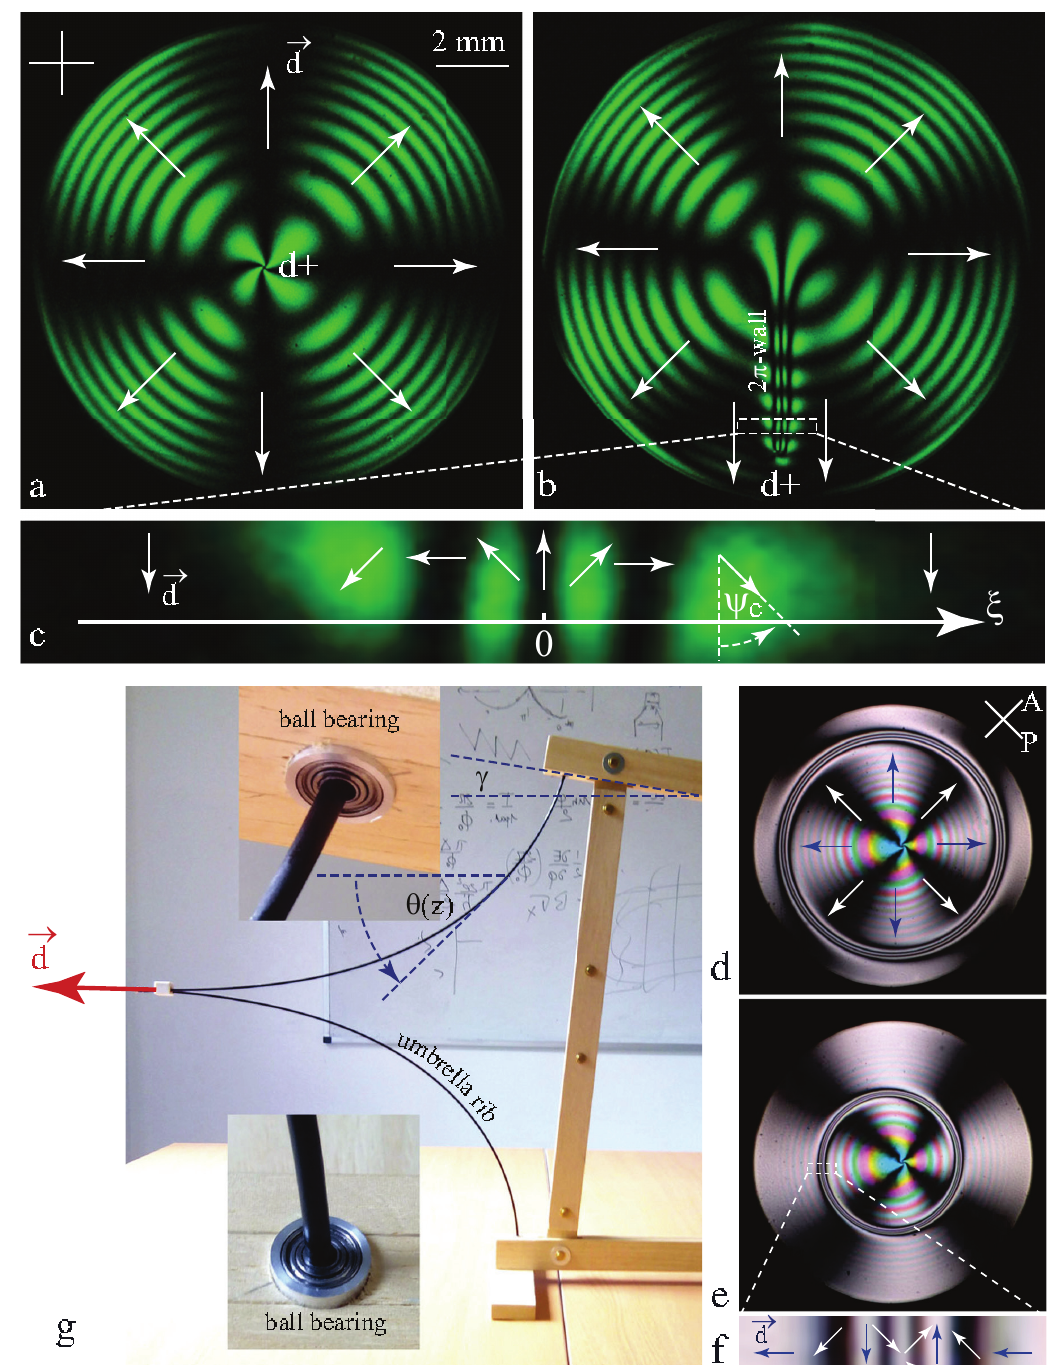
Figure 8. Cuneitropism. a) Radial dowser field with d // grad h. b) 2 π -wall connecting the eccentric dowson d+ with the center of the radial dowser field. d,e) Radial dowser field with a shrinking circular 2 π -wall. c,f) Structures of 2 π -walls. g) Mechanical model explaining the cuneitropism of the dowser texture.